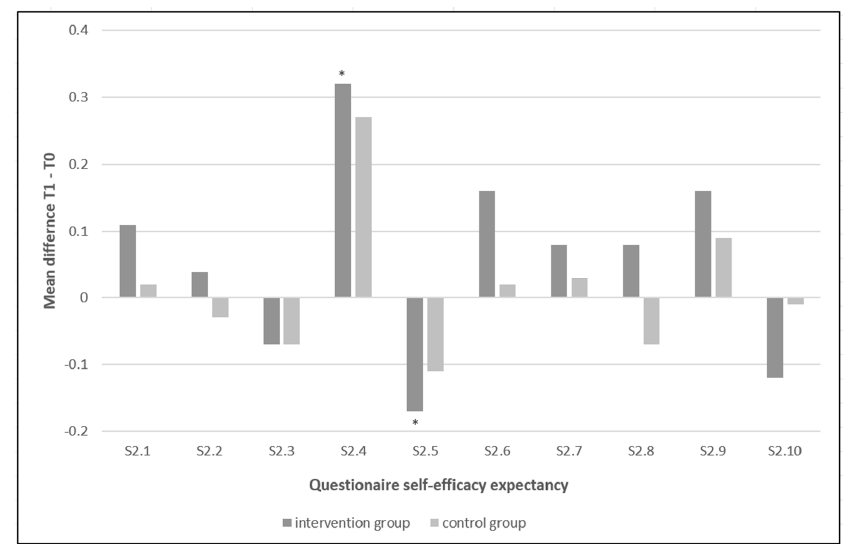
Figure 2. Questionnaire self-efficacy expectancy. (* significant at p <